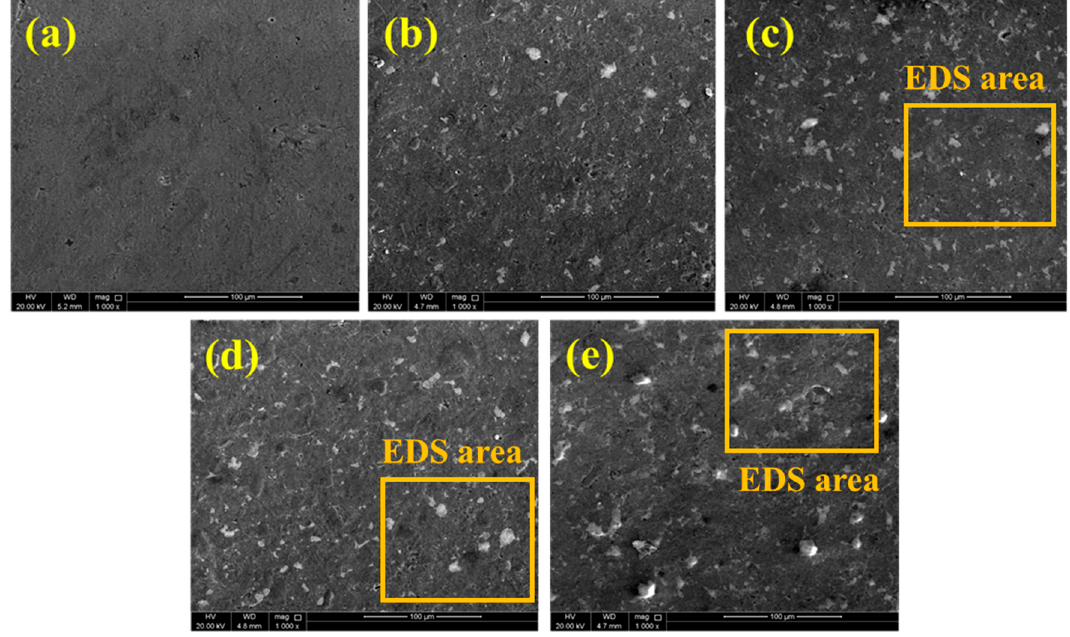
Figure 3. FE-SEM images of ( a ) pure Al, ( b ) Al-5SiC, ( c ) Al-5SiC-3ZrO 2 , ( d ) Al-5SiC-6ZrO 2 , and ( e ) Al-5SiC-9ZrO 2 nanocomposites with marked areas for energy dispersive X-Ray spectroscopy (EDS).